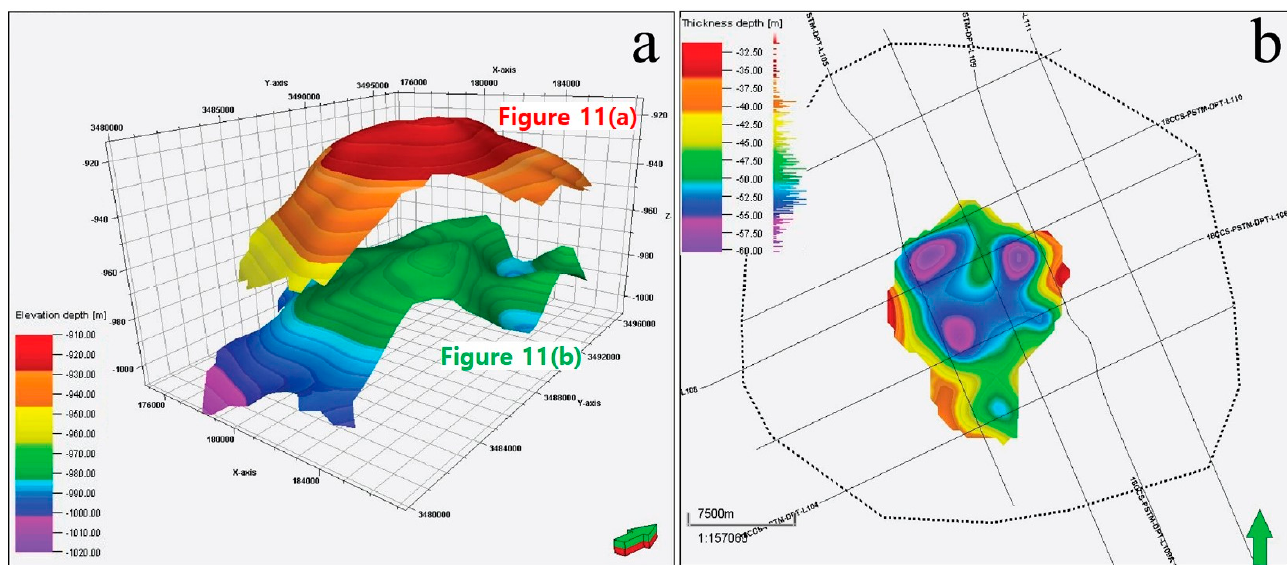
Figure 12. ( a ) Overlapping tops of the volcanic mounds before (Figure 11a) and after (Figure 11b) the depth processing. ( b ) The contour map represents vertical differences between Figure 11a,b.